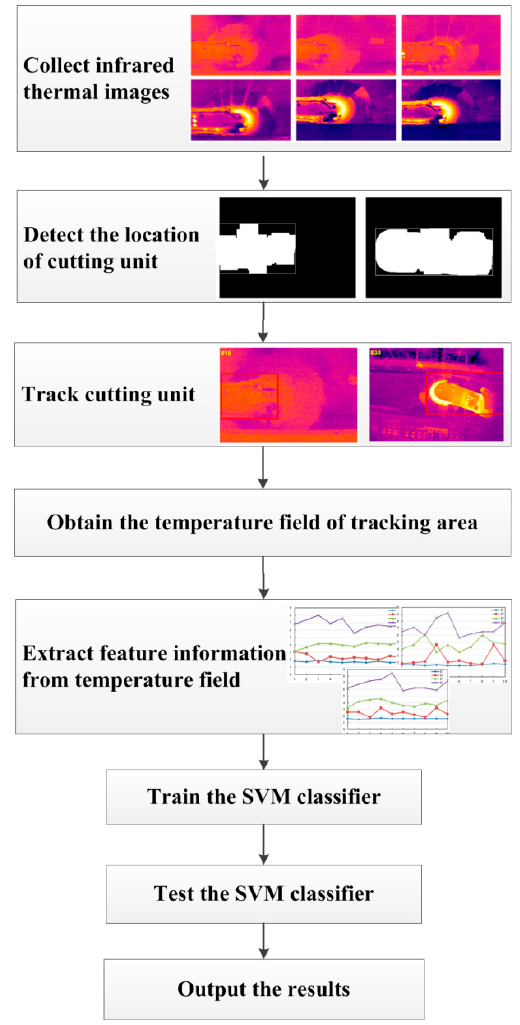
Figure 8. Online recognition system of a shearer cutting state using infrared thermal images.